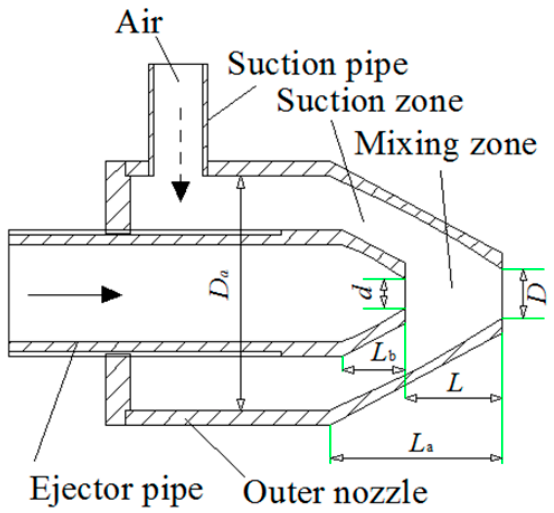
Figure 2. Structural schematic of the double cosine self-aspirated nozzle.